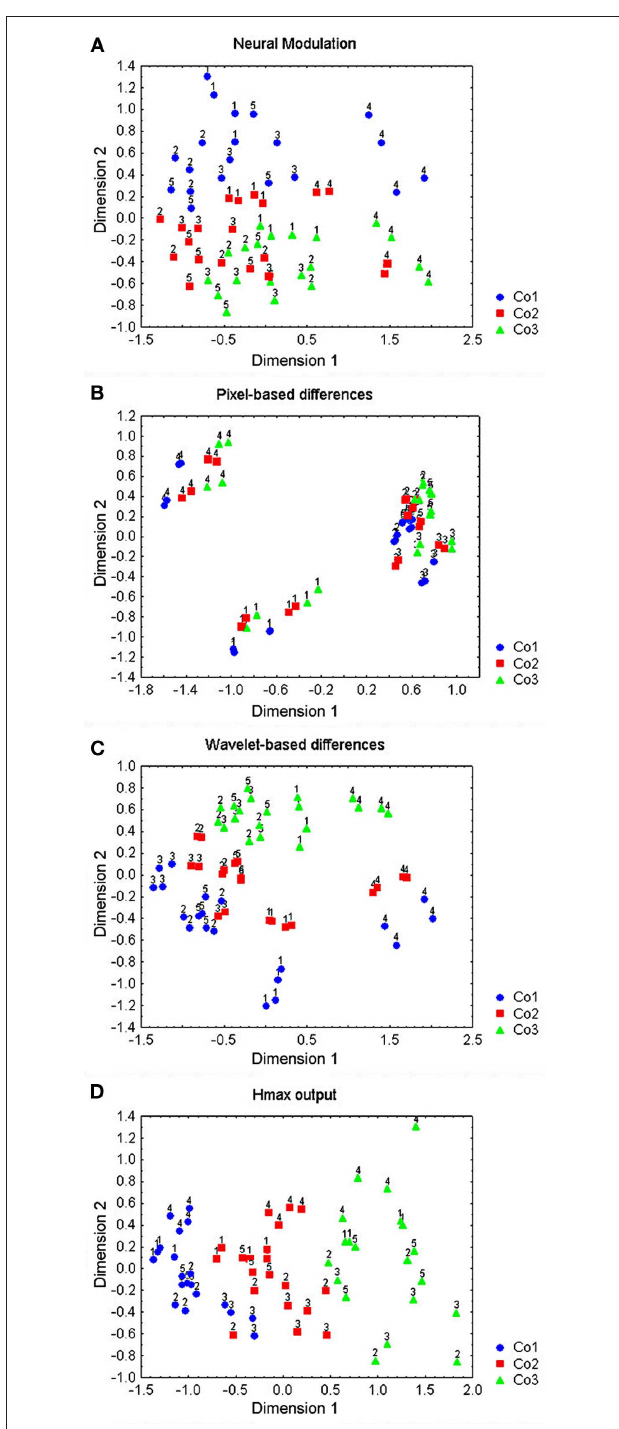
Figure 5 | Two-dimensional MDS-solutions for the shapes represented in Figure 1. The circles represent simple shapes, the squares medium complex shapes and the triangles highly complex shapes. The numbers at each data point indicate to which row in Figure 1 the shape belongs. (A) Solution for the neural Euclidean distances, (B) solution for the pixel-based distances, (C) solution for the wavelet-based distances, and (D) solution for the HMAX